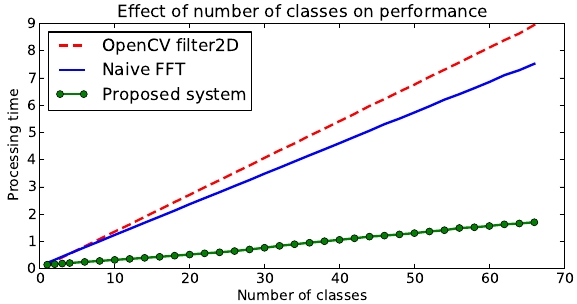
(b) Effect of the number of feature maps on performance. The kernel is set to 8 × 8 pixels, and the number of classes to 20 .